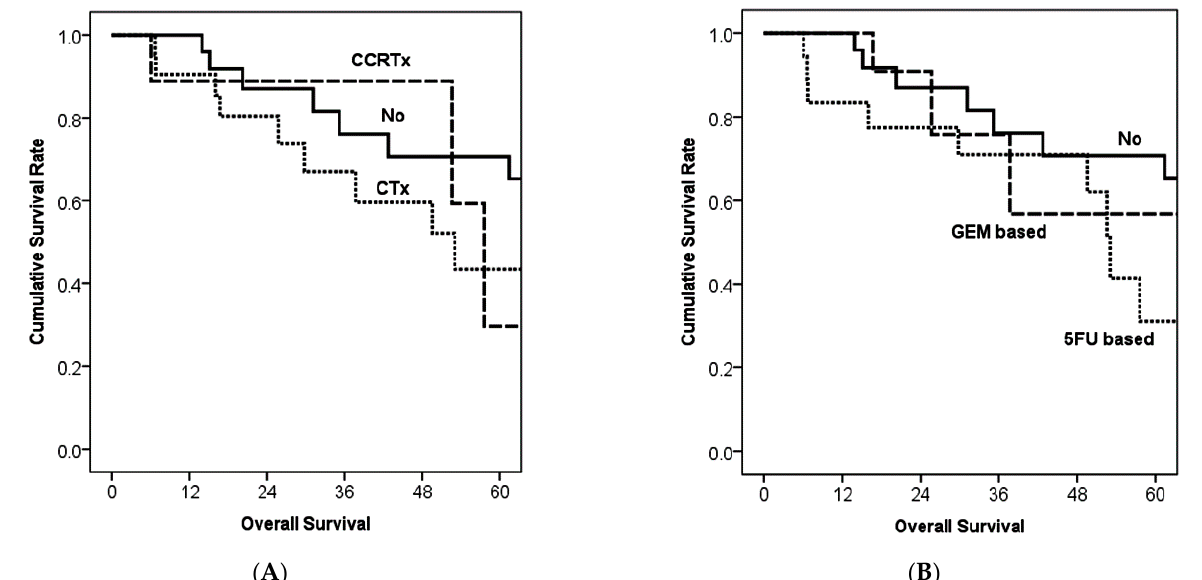
Figure 3. Kaplan–Meier survival curves according to the adjuvant therapy and its regimen. ( A ) Modalities of adjuvant therapy did not show significant survival differences. p value was 0.115 between no therapy and chemotherapy, 0.929 between chemotherapy and concurrent chemo-radiation therapy, and 0.199 between no therapy and concurrent chemo-radiation therapy. ( B ) In comparisons according to chemotherapy regimens, 5-fluorouracil-based chemotherapy showed better survival than no therapy ( p = 0.035). However, gemcitabine-based chemotherapy did not show a significant survival difference compared with no therapy ( p = 0.518) or compared with 5-fluorouracil-based chemotherapy ( p = 0.196). Table 2. Survival analysis for identifying factors affecting patients’ overall survival using a Cox proportional hazard model.